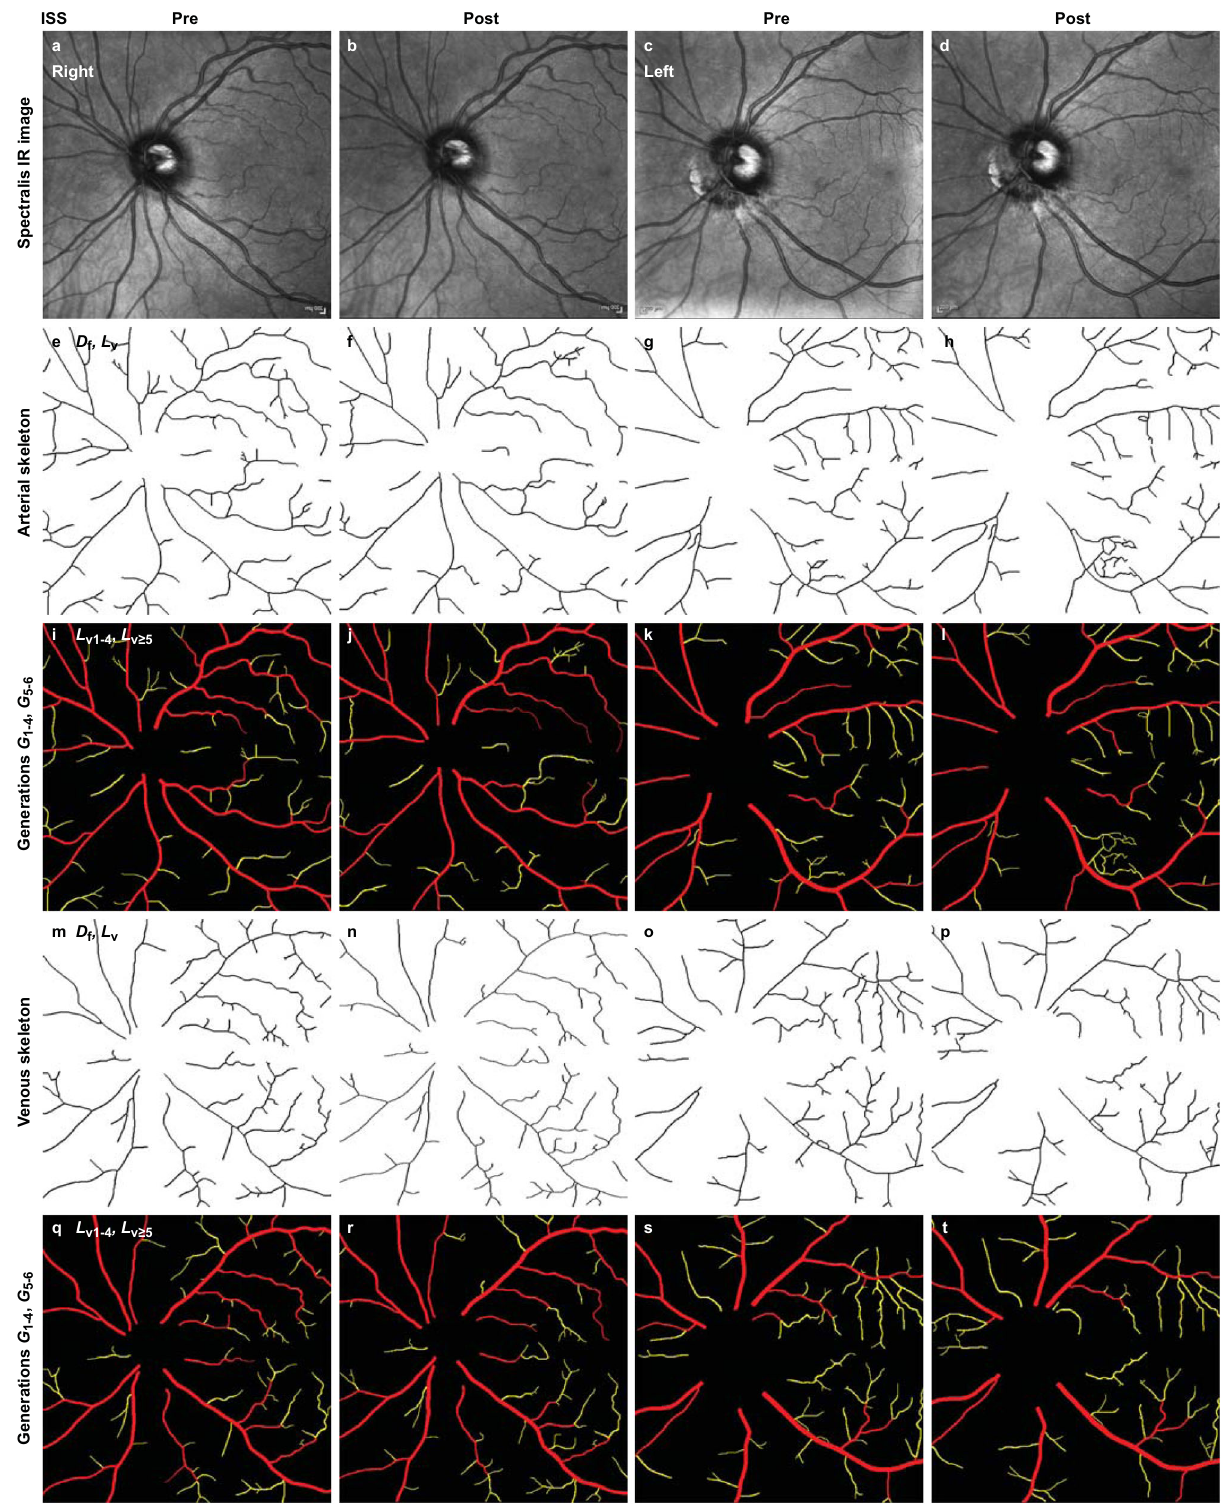
Fig. 4 Representative vascular decreases in the retinas of an astronaut after 6 months in microgravity. Compared to a scale of 100% established by retinal arterio-venous loss in a crew member diagnosed with SANS 25 , arterial and venous density decreased in post- fl ight right and left retinas of this crew member by 35% and 8%, respectively. As for HDT subjects (Fig. 3), vascular trees extracted from grayscale images ( a – d ) were analyzed by VESGEN as skeletons ( e – h , m – p ) and branching trees grouped into large ( G v1-4 , red) and small ( G v5-6 , yellow) generations ( i – l , q – t ). Pre- to post- fl ight arterial and venous results for D f in right retina, 1.38 to 1.35 and 1.36 to 1.35, respectively; for L v , 14.4 to 12.6 × 10 – 4 μ m/ μ m 2 and 13.0 to 12.4 × 10 – 4 μ m/ μ m 2 . Similarly for left retina, 1.35 to 1.35 and 1.34 to 1.33; 12.4 to 12.6 × 10 – 4 μ m/ μ m 2 and 11.6 to 11.1 × 10 – 4 μ m/ μ m 2 . For astronauts, Spectralis IR imaging was centered on the optic disc, not on the macula as for HDT subjects. Scale bars ( a – d ), 200 μ